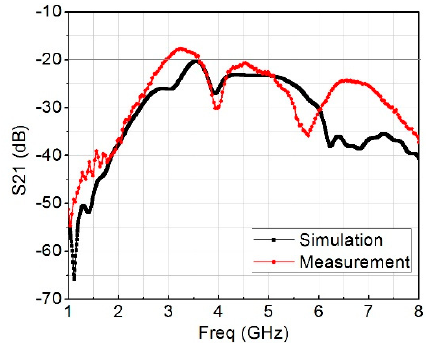
Figure 9. Measured and simulated S21.